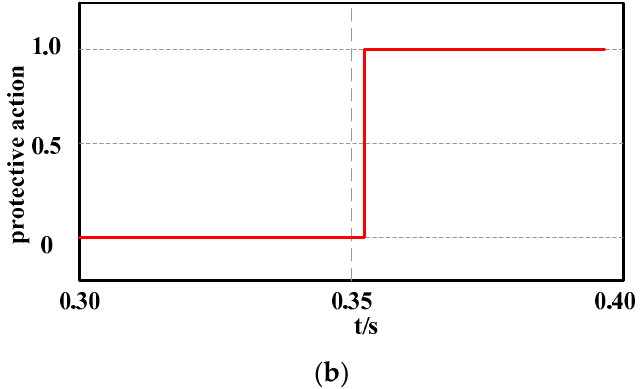
Figure 10. Comprehensive impedance and protection action of positive sequence component of Line1 ground fault. ( a ) Positive sequence integrated impedance. ( b ) Protection action condition.